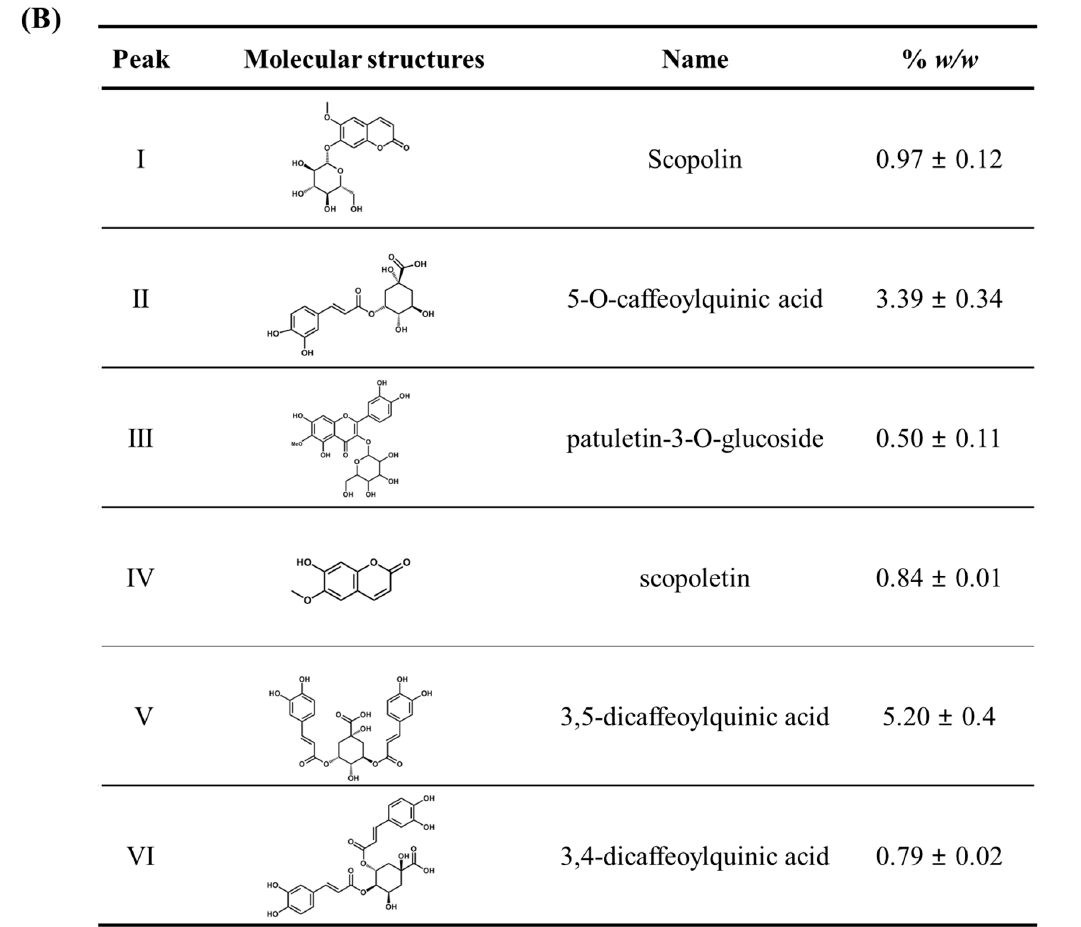
Figure 1 Figure 1. The contents of the individual bioactives identified in Artemisia iwayomogi extract (AI). ( A ) A representative high performance liquid chromatography (HPLC) chromatogram of the compound present in the extract is shown. The sample was run three times at 330 nm; ( B ) the molecular structures and concentrations (% w / w ) of compounds identified in